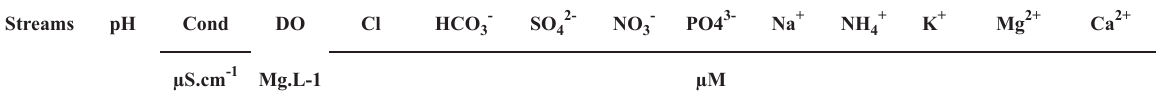
Comparision of mean concentration of conductivity (Cond); dissolved oxygen (DO), HCO 3- , Na + , Mg 2+ , K + , Ca 2+ , Cl - , NO 3- , SO 4 2- , PO 4 3- between tropical watersheds with different land uses. Cond (µS.cm -1 ); ions (µM.L -1 ).